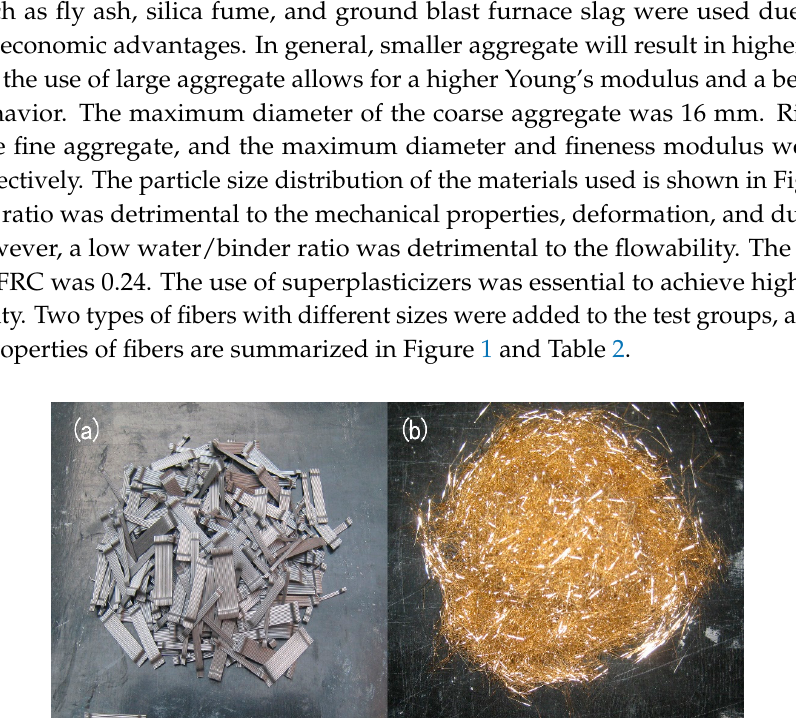
Table 1. Material proportions.